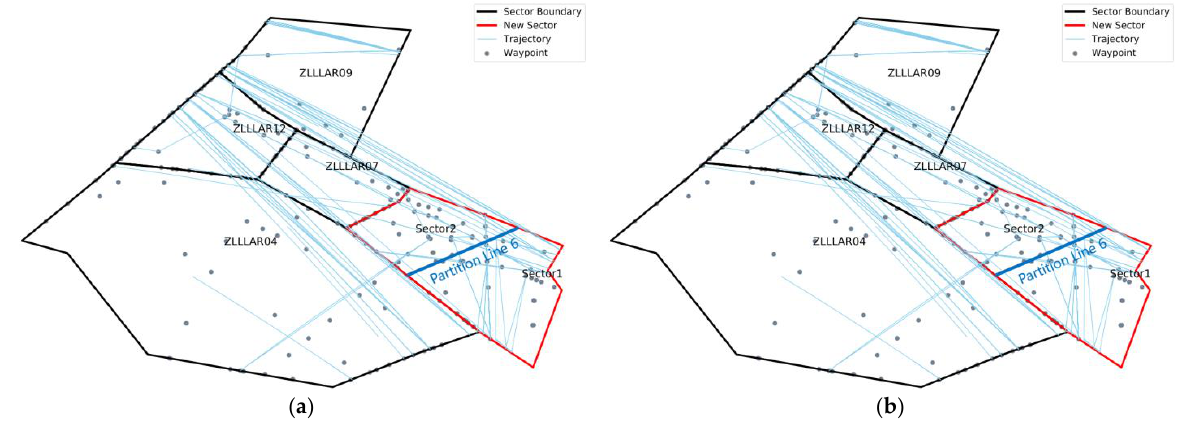
Figure 13. ( a ) 14:00 – 15:59 After one-stage; ( b ) 14:00 – 15:59 After two-stage. Table 9. 14:00 – 15:59 Workload values for each sector before and after optimization. Before After One-Stage